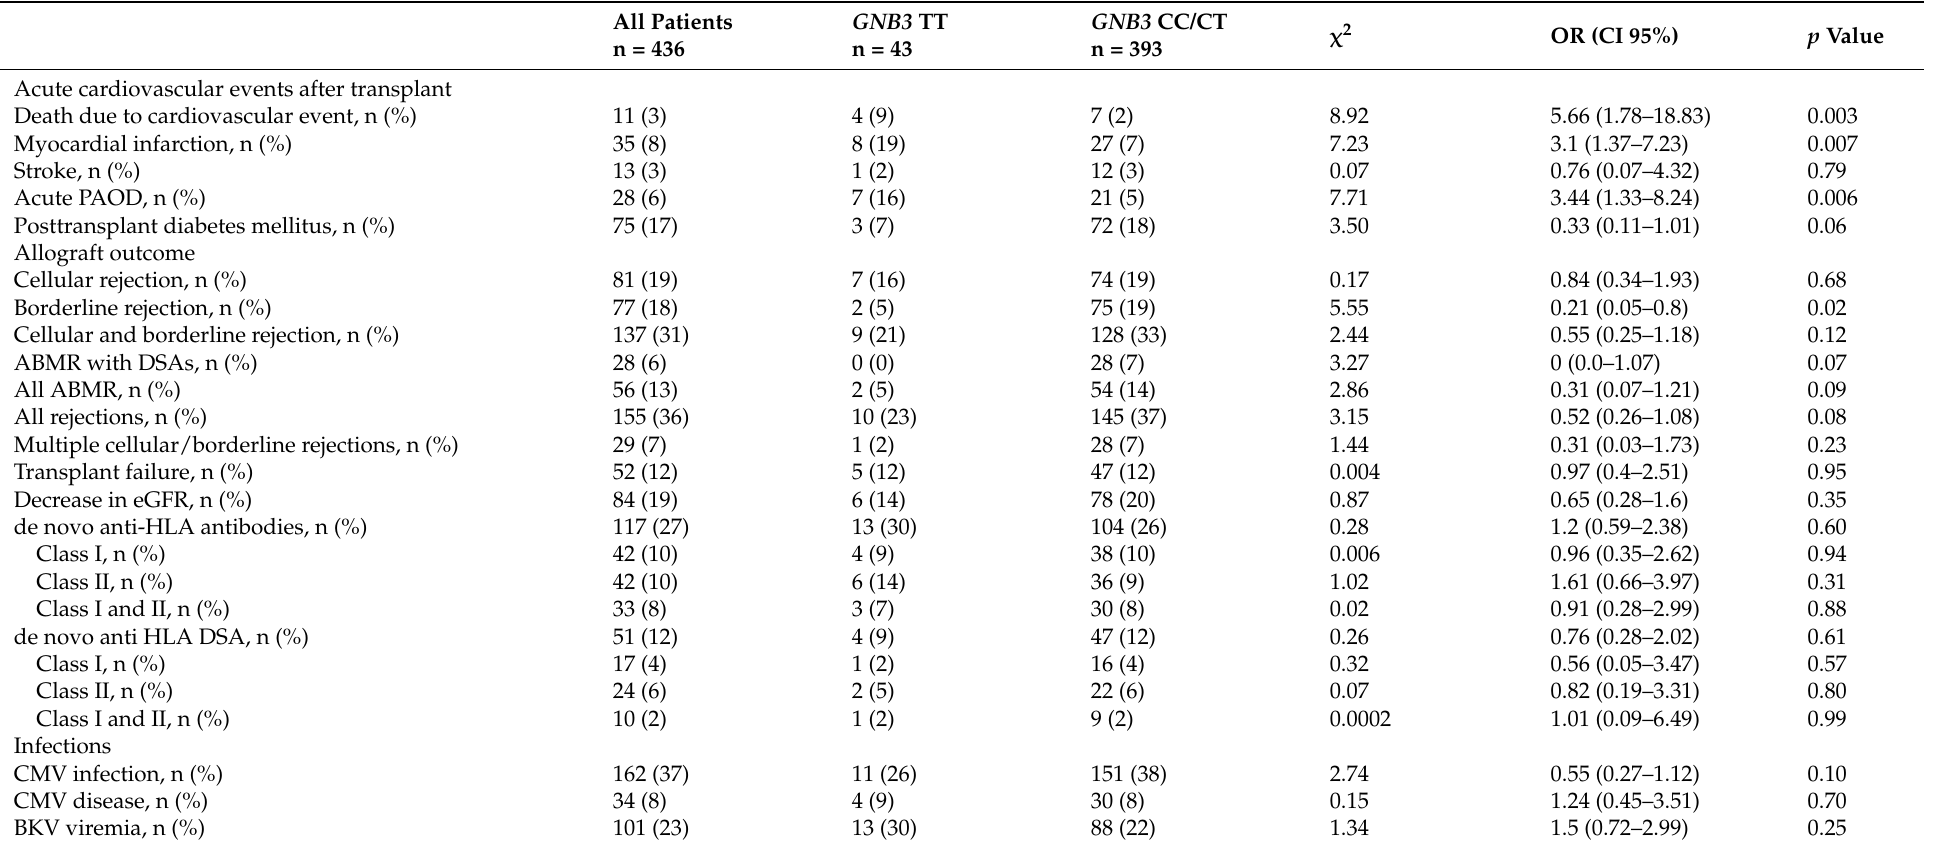
Table 2. Characteristics of acute cardiovascular events after transplant, as well as renal allograft outcome, infectious complications, and occurrence of malignant tumors after renal transplant among carriers of the TT genotype or the CT/CC genotype of GNB3